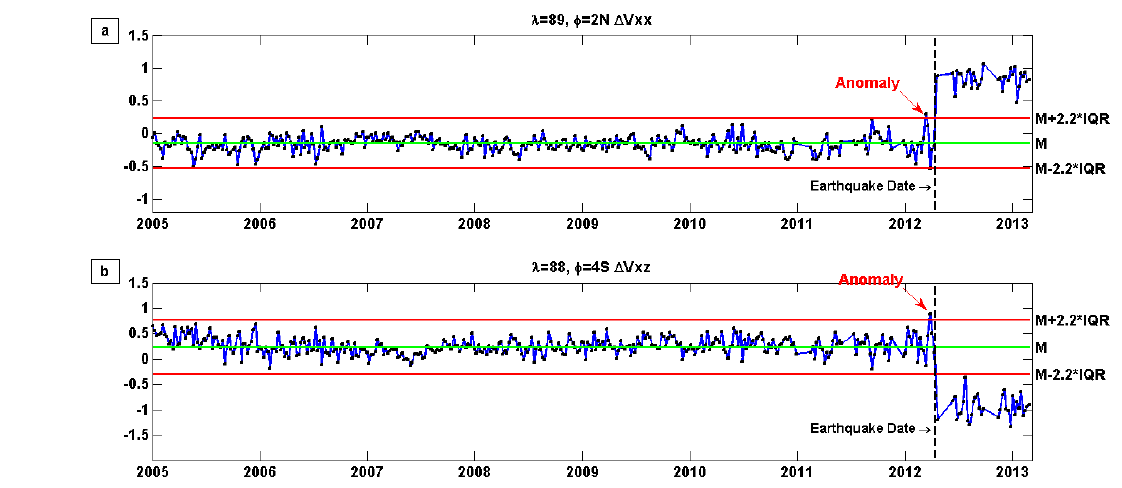
Figure 11. Same as Figure 5 for Indian